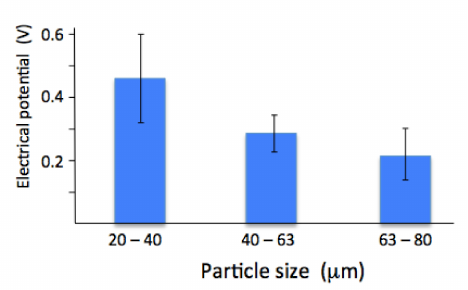
Figure 4. Electrical surface potential measured by Kelvin probe AFM on coatings made from 20–40 µ m, 40–60 µ m and 60–80 µ m powder.